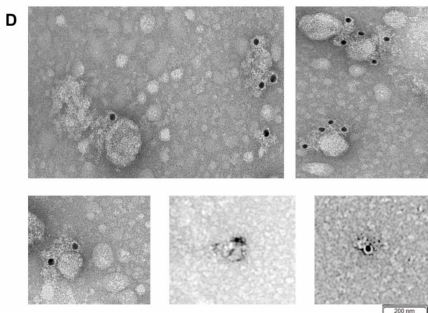
Figure 3. ( A ) The presence of EVs in blank BSA medium before and after (fraction 8–9) ODG ultracentrifugation was tested using two EV specific (CD63, CD9) and one non-EV specific antibodies (Ago-2). Blank BSA medium (SOF+ITS+BSA) was analyzed before ( B ) and after ( C ) OptiPrep™ density gradient (ODG) ultracentrifugation (EVs isolation procedure) by transmission electron microscopy after immunogold labeling with anti-CD63 antibodies. ( D ) EVs isolated from concentrated conditioned embryo culture medium were also analyzed by this method. No membrane-associated gold particles binding was observed in blank BSA medium before and after OptiPrep™ density gradient (ODG) ultracentrifugation ( B , C ) but positive immunogold labeling was observed in EVs isolated from concentrated conditioned embryo culture medium. Black dots (10 nm in size) indicate membrane-associated gold particles.